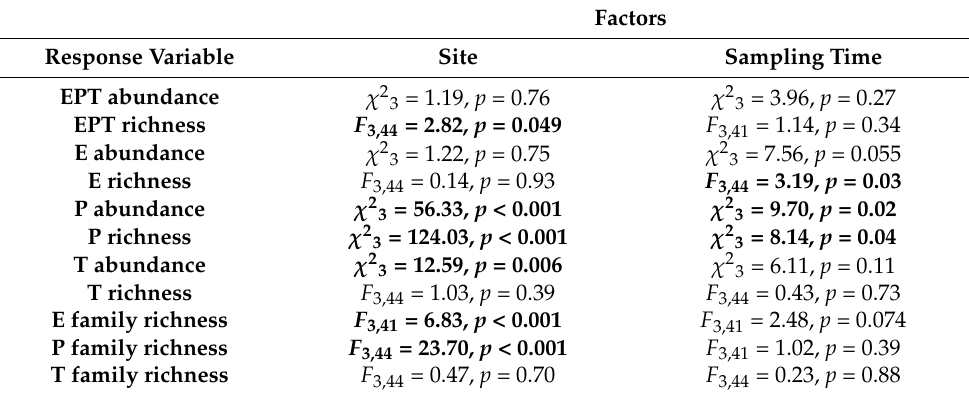
Table 5. Results of testing the significance of differences within factors site and sampling time (both four-level factors) in given response variables using Generalised linear models (GLMs) or Generalised linear mixed-effects models (GLMMs). Significant ( p < 0.05) results are in bold text. No significant interaction between site and sampling time was detected for any response variable ( p > 0.05). E—Ephemeroptera, P—Plecoptera, and